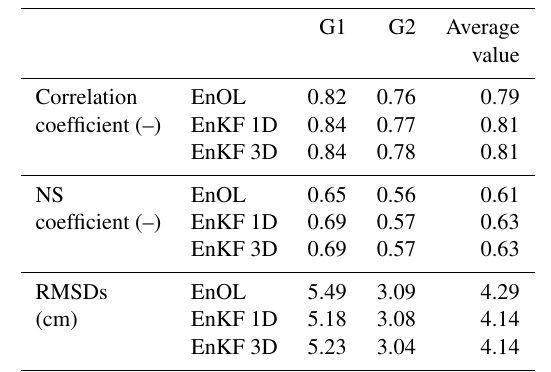
Table 6. Statistical values of the streamflow computed from the river stream gauge measurement and GRACE DA estimates be- tween April 2002 and December 2010. The average values are calculated by averaging the estimated statistical values from both gauge locations.